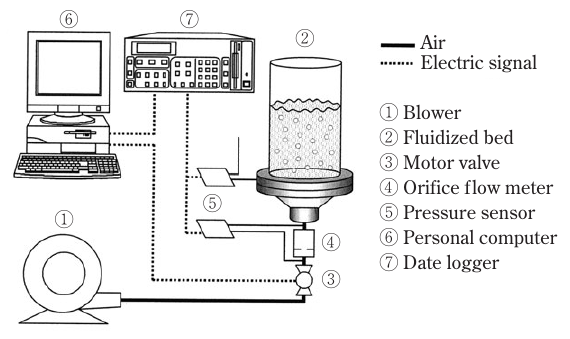
Fig. 2 Schematic drawing of the experimental